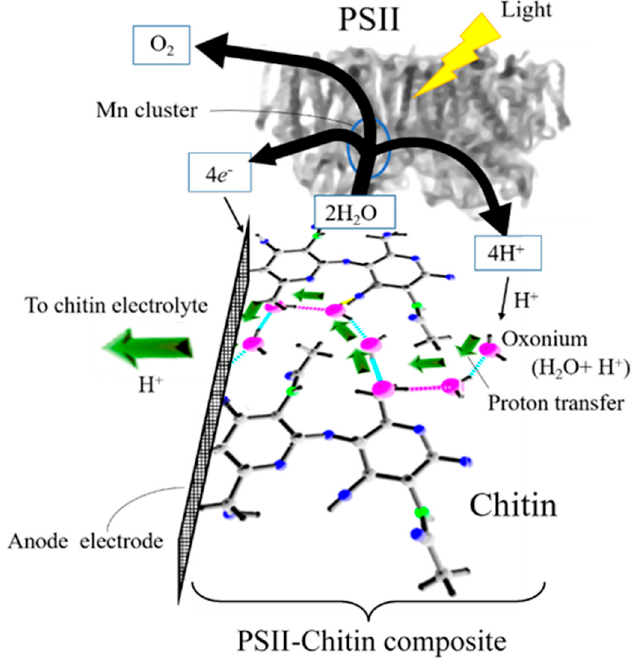
Figure 11. Schematic diagram of proton generation by the light irradiation and proton transfer in the PSII–chitin composite.